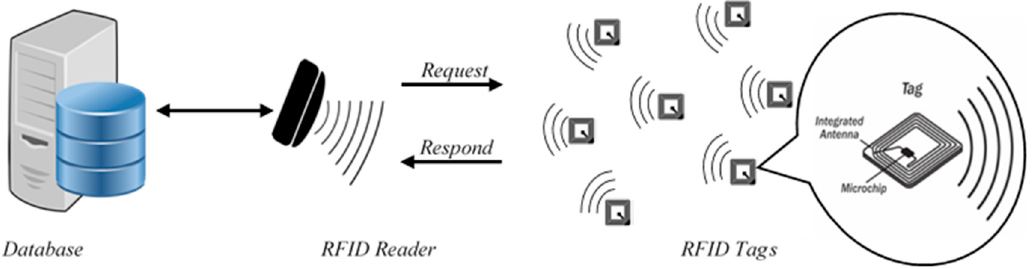
Figure 1. Basic Radio Frequency Identification (RFID) Model.